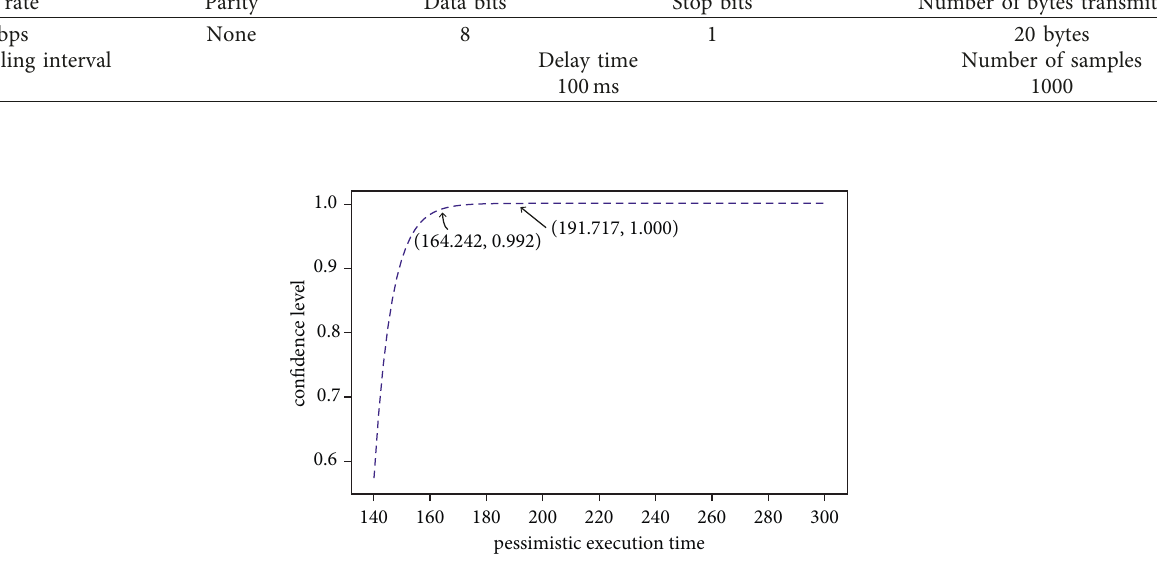
Figure 5: The confidence level against the pessimistic acquisition time estimate.